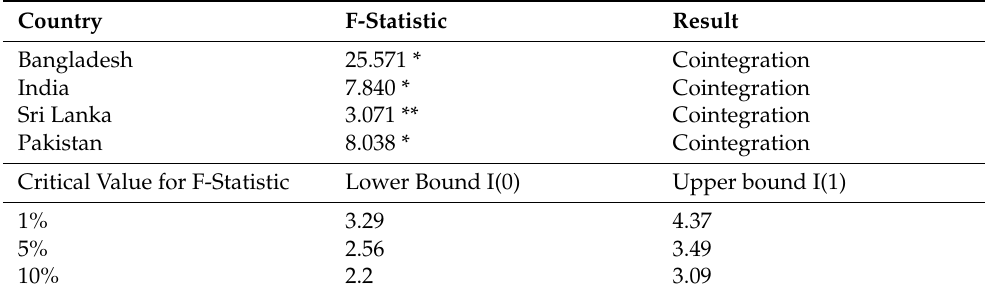
Table 3. Results of the ARDL test for cointegration. Model: LnCo2 = f(LnE, LnY, Ln Y 2 , Ln T + , Ln T − ). Country F-Statistic Result